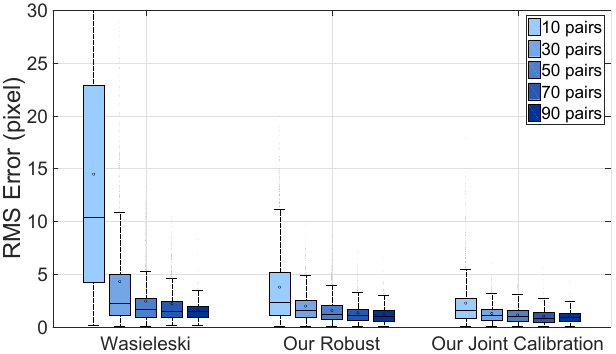
Figure 13. RMS distance error by the number of scan/image pairs: our joint calibration is within the 10% error bound with 30 pairs, Wasielewski with 90 pairs and our robust method with 50 pairs.